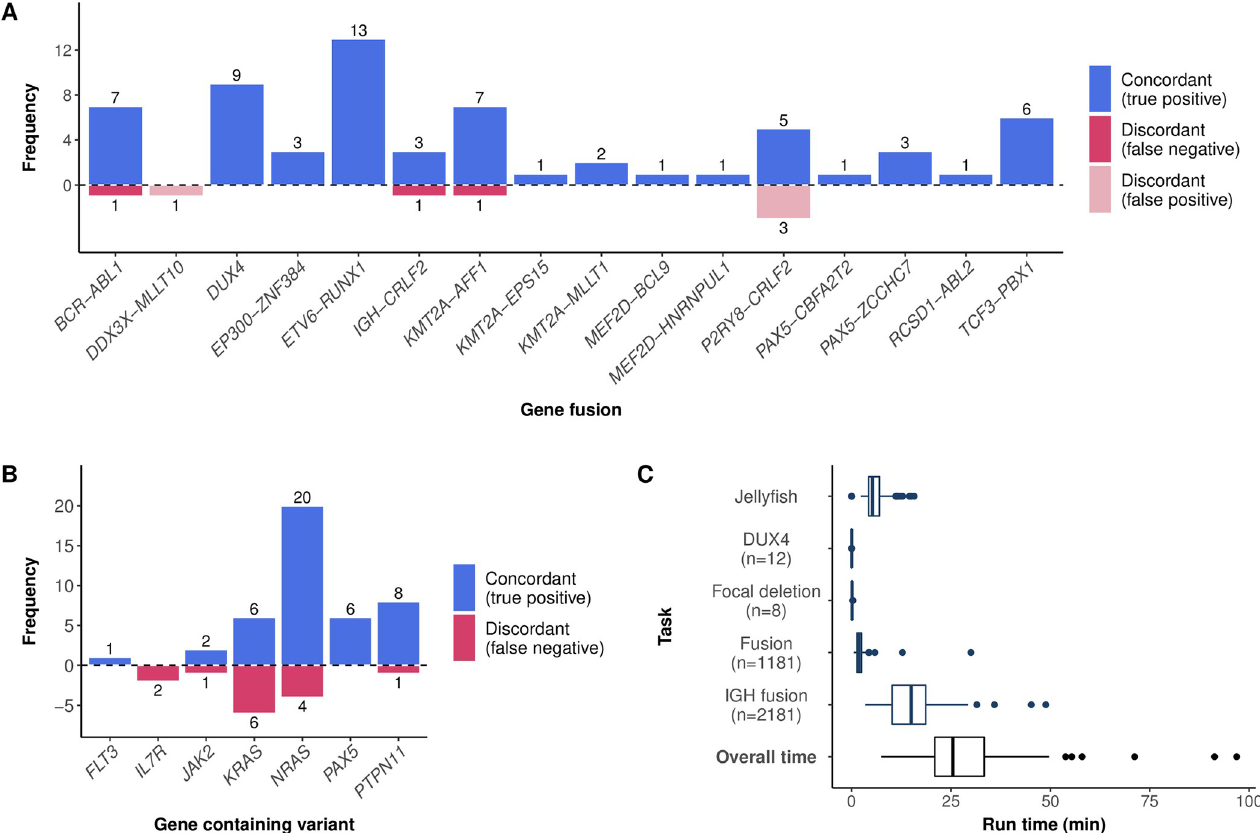
Fig 4. RaScALL accurately detects subtype defining genetic variants in a validation cohort of 100 B-ALL patient samples. Fusions (A) and variants (B) detected by RaScALL and their concordance with clinically reported alterations. The vertical axis indicates the number of detected alterations while the horizontal axis indicates the specific gene fusion (A) or gene in which the variant occurred (B). Concordant results are indicated in blue and discordant indicated in dark red for false negative results and light red for false positive results. (C) Runtimes for RaScALL in minutes. Wall clock time for 100 samples represented as boxplots. The vertical axis indicates the separate run times for indexing of raw data and assessment of variants with different target sets. The Number of targets in each set is indicated.